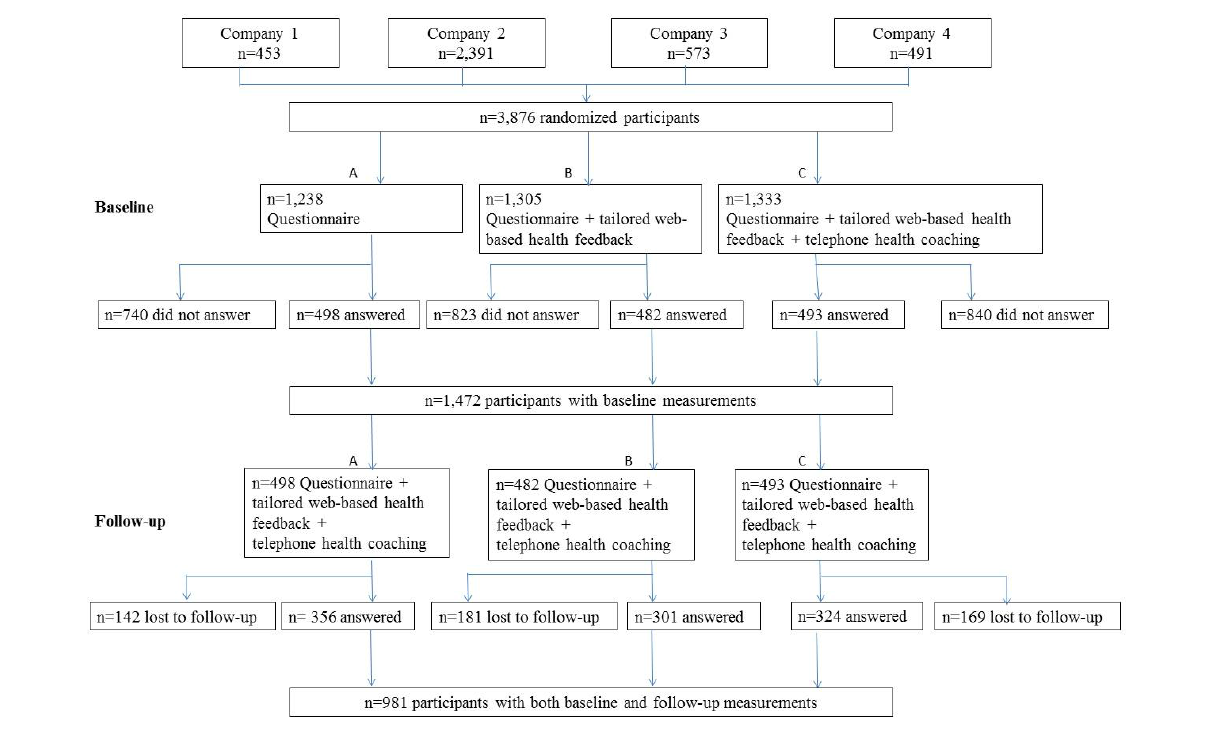
Figure 4. Flowchart of the study design. A total of 3876 employees were asked to participate in the study and were automatically randomized to 1 of the 3 groups: (1) control group or (2) intervention Web, or (3) intervention Web + telephone. All the 3 groups received an identical questionnaire on health and lifestyle behaviors, only the interventions differed. Nine months later, all participants received a follow-up questionnaire and interventions web +